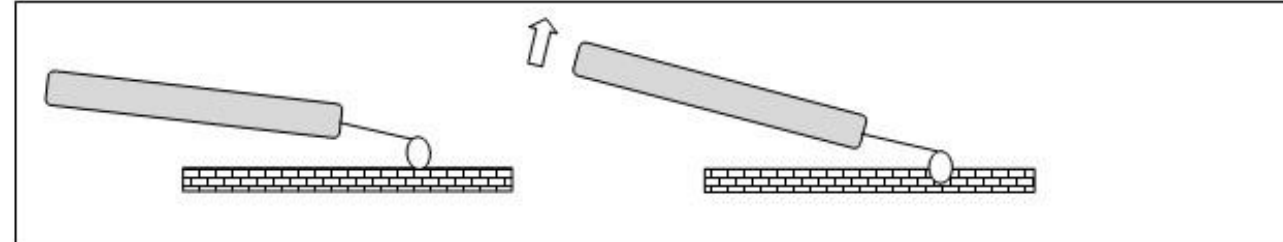
Figure 9. Correlation with hysteroscope angulation and tissue depth.